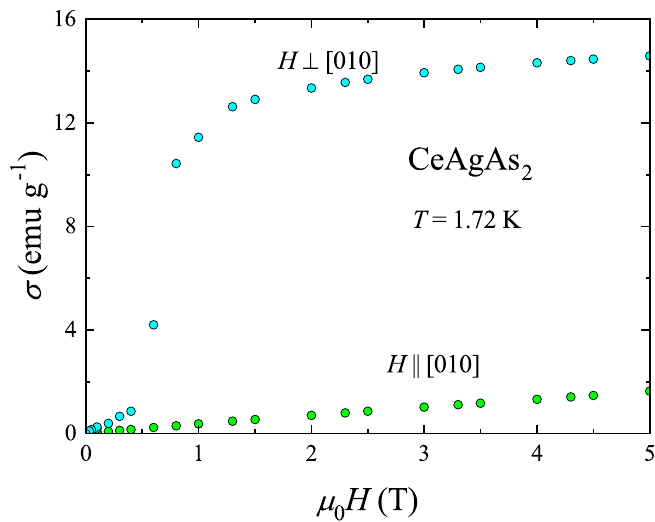
Figure 3. Field dependencies of the magnetization of single-crystalline CeAgAs 2 measured at 1.72 K in magnetic field oriented along and perpendicular to